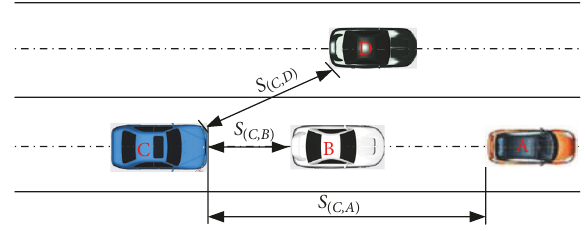
Figure 4: Change of track